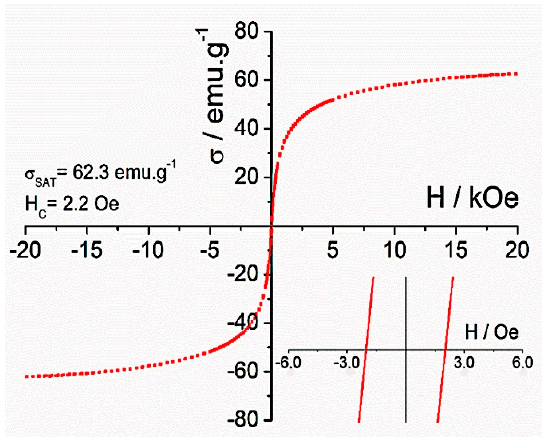
Figure 2. Magnetization curve for Fe 3 O 4 @SiO 2 nanoparticles, at room temperature, showing a negligible hysteresis effect (Hc = 2.2 Oe) in the expanded scale (inset).